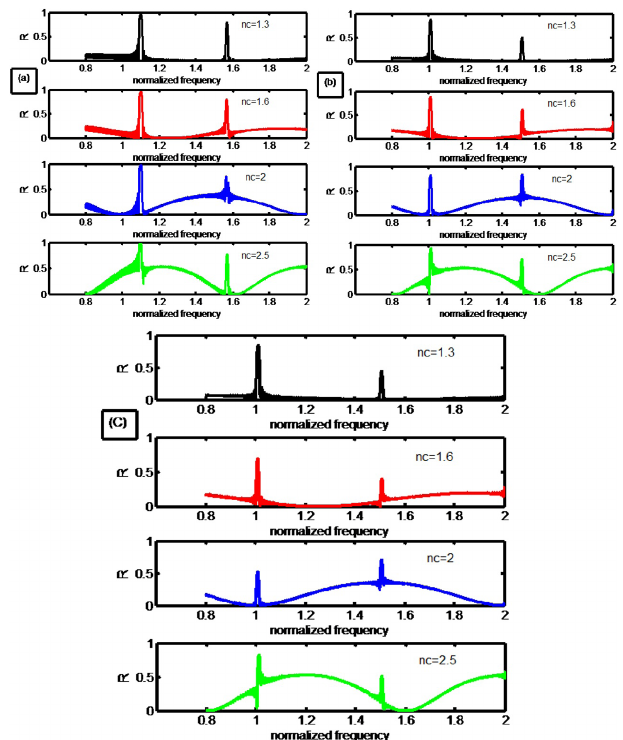
Figure 6. Reflectance spectra versus normalized frequency of the three periodic superconducting PC and for different values of refractive index of the dielectric cap layer.